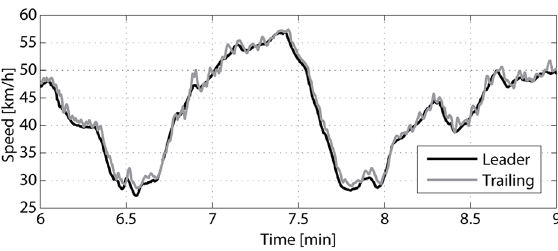
Fig. 11. Speed of the two vehicles in the urban area